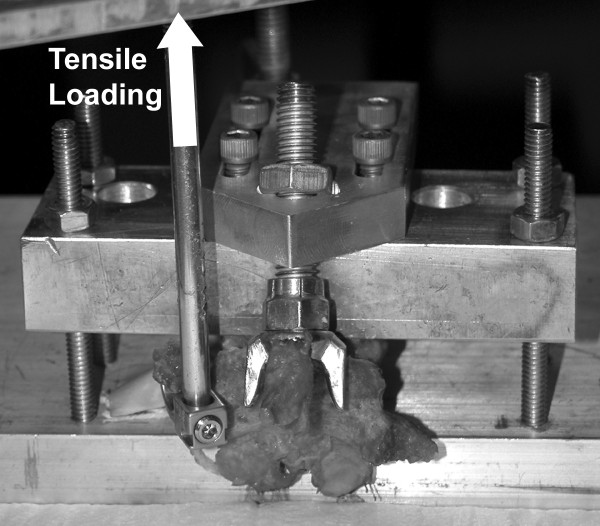
Custom fixture holding each vertebral body rigidly while an upward (caudally directed) force was applied to the end of the TP using a standard hook. Vertebrae were held inverted with the spinous process supported.